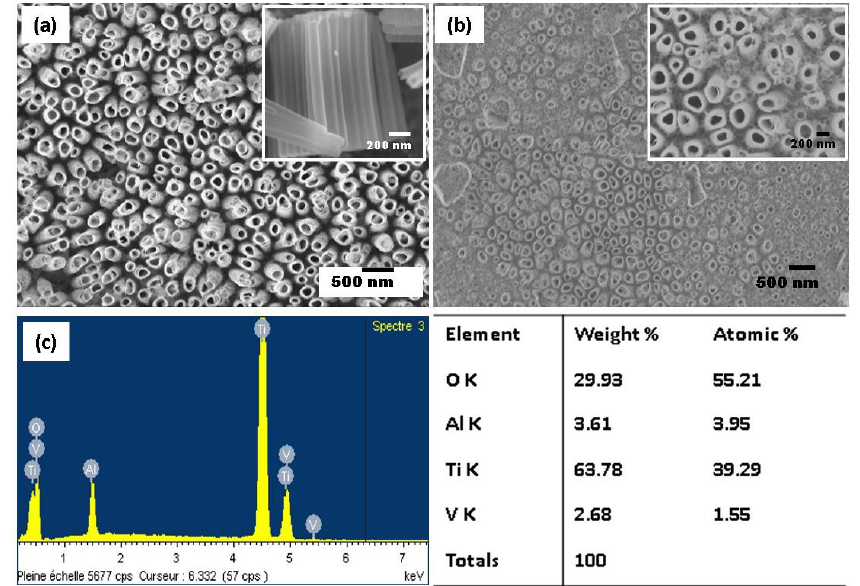
Figure 2. SEM images of TiO 2 NTs obtained from the anodization of Ti-6Al-4V alloy in fluoride ethylene glycol electrolyte with different water contents: 20 wt% H 2 O (top view in the inset) ( a ) and 25 wt% H 2 O ( b ), and the energy-dispersive spectroscopy (EDS) elemental spectrum of the anodized Ti-6Al-4V alloy ( c